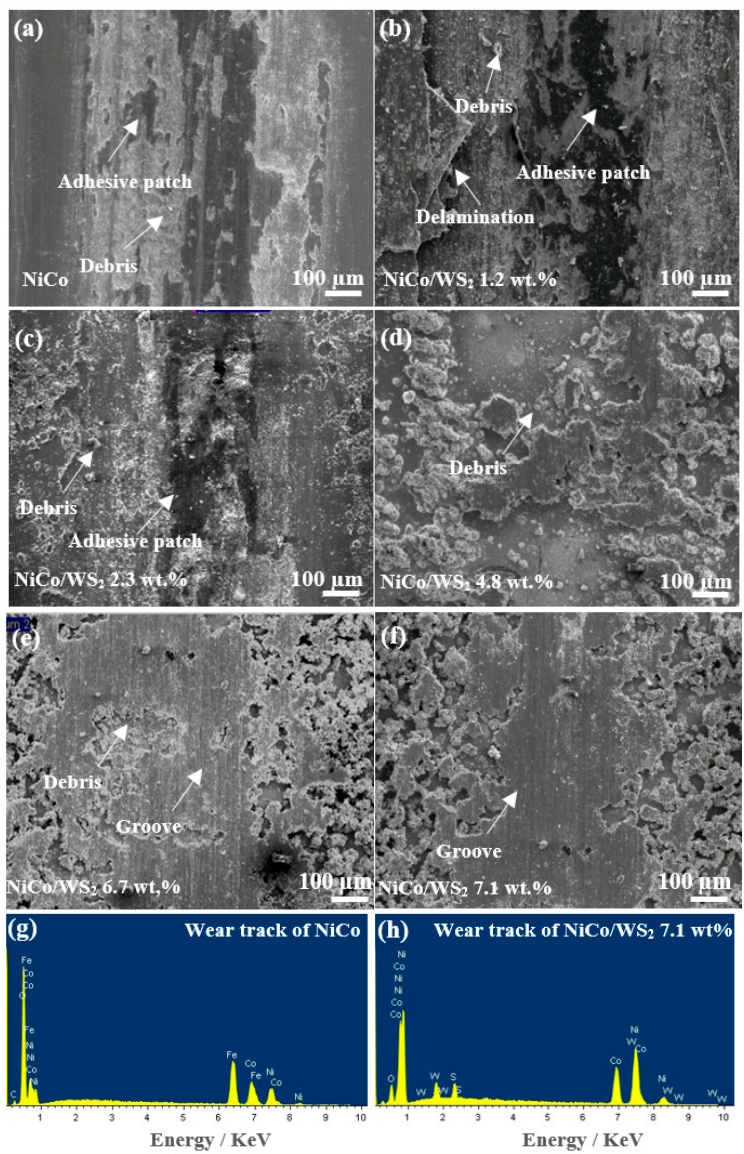
Figure 7. ( a – f ) SEM images of the wear tracks on various Ni–Co/WS 2 coatings; ( g – h ) EDS spectra of the wear tracks on Ni–Co coating and Ni–Co/WS 2 7.1 wt.% coating. Table 1. Composition of wear tracks on Ni-Co and Ni-Co/WS 2 coatings after friction testing. Element Ni-Co/WS 2 Ni-Co/WS 2 Ni-Co/WS 2 Ni-Co/WS 2 Ni-Co/WS 2 Element (wt.%) Ni-Co 1.2 wt.% 2.3 wt.% 4.8 wt.% 6.7 wt.% 7.1 wt.%